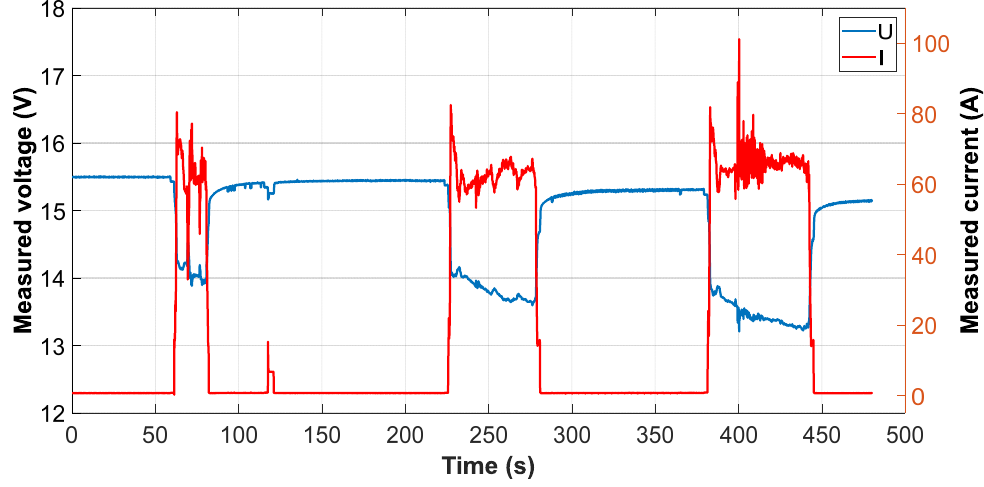
Figure 25. Measured voltage and current of the system.